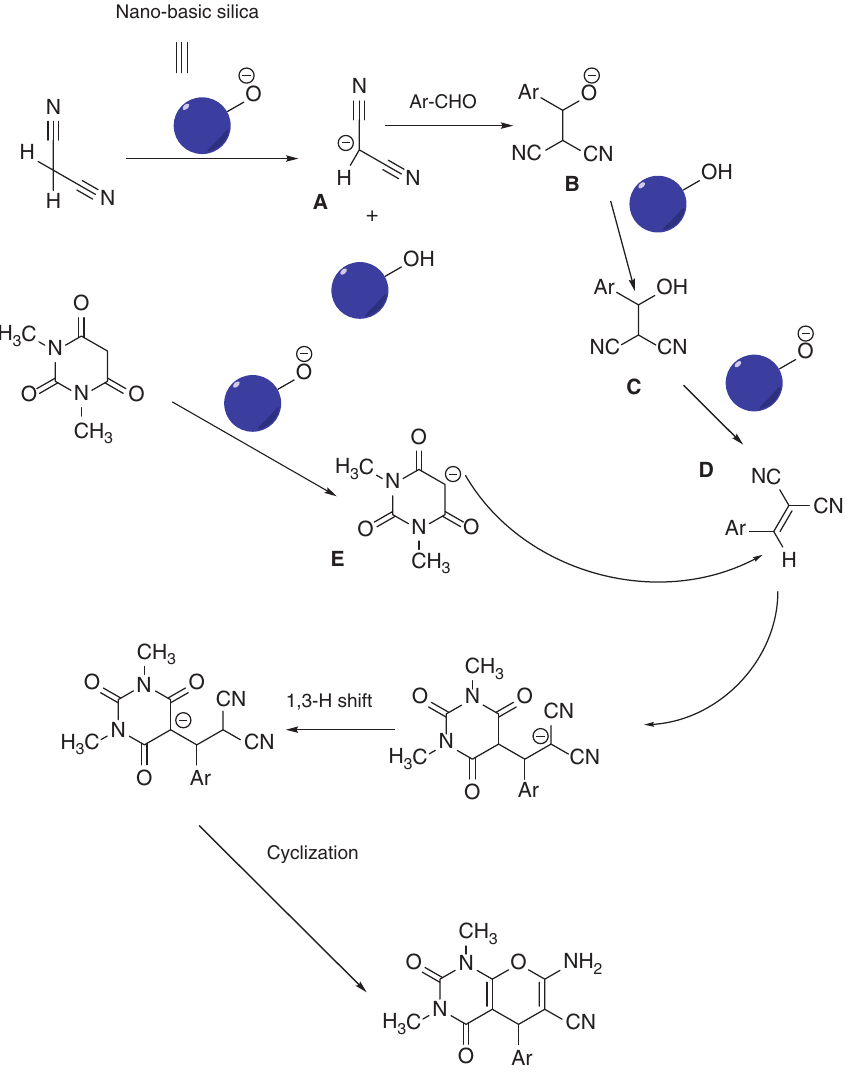
Scheme 2: Proposed reaction